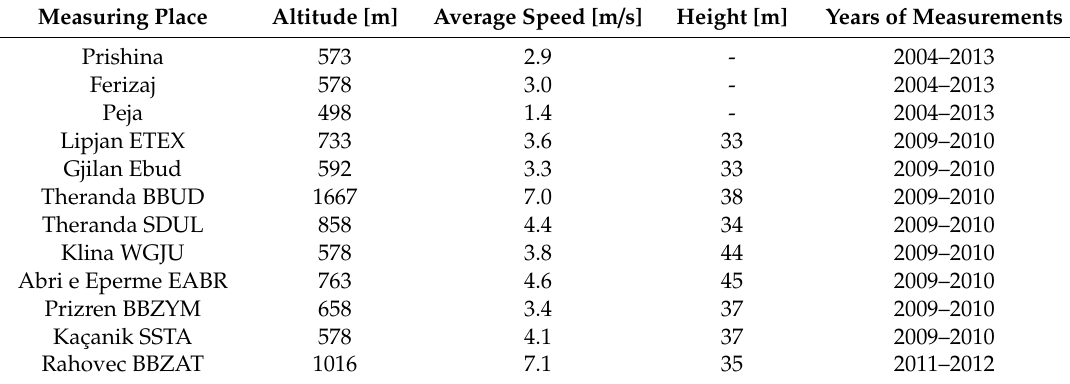
Table 1. Measuring location of wind speed at different zones in Kosovo [17–19].